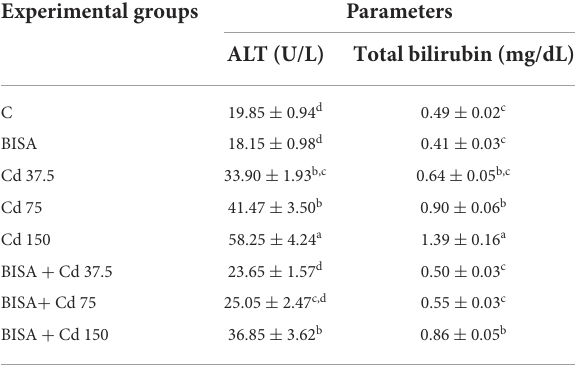
TABLE 3 Effect of α -bisabolol on serum ALT and bilirubin levels in ducks receiving CdCl 2 in feed for 4 weeks. Experimental groups Parameters ALT (U/L) Total bilirubin